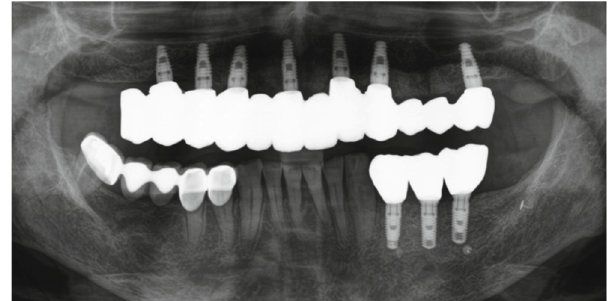
Figure 3: Section of a DPT immediately after cementation of the single